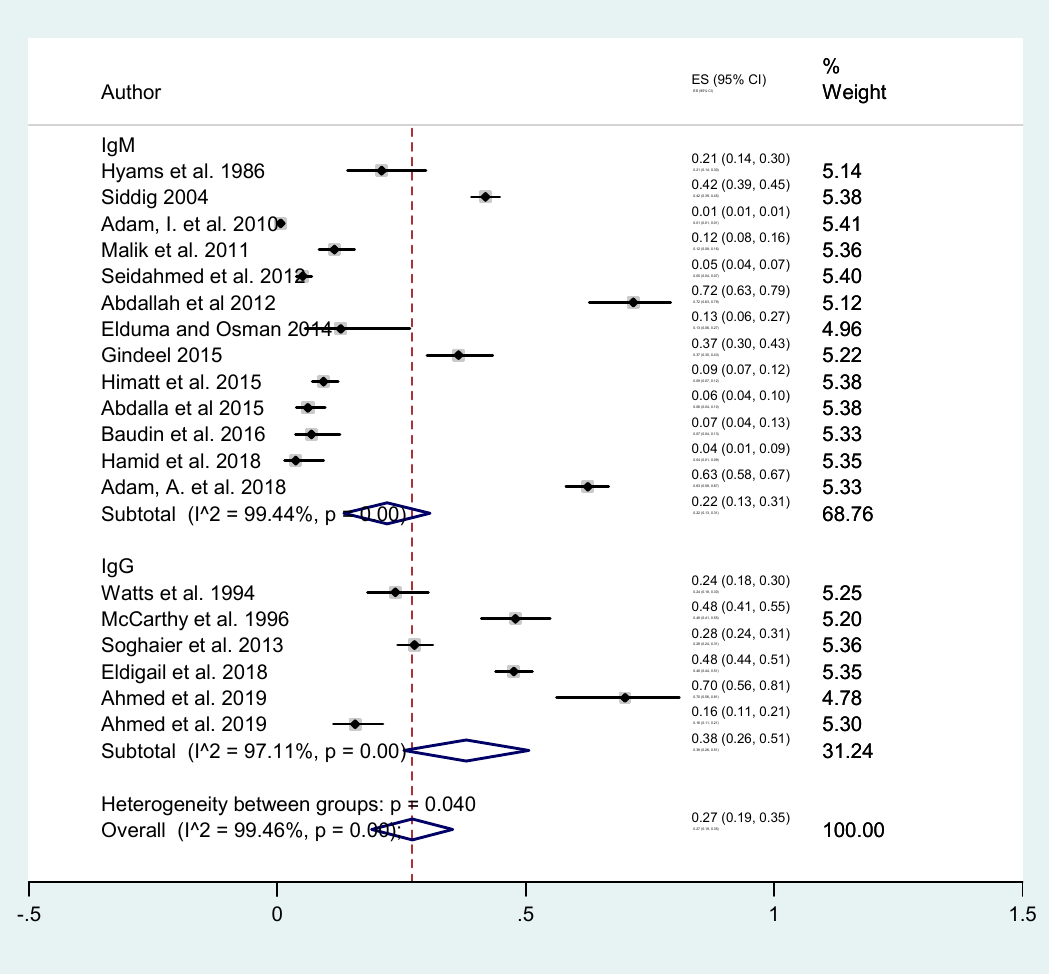
Figure 5. The estimated burden of dengue based on sub-group analysis according to diagnostic test. Additionally, the regional prevalence of the disease was estimated by sub-group analysis according to the geographical location of the studies site: North, East, South, Central, or Western Sudan (Figure 6). The estimated seroprevalence of DENV infections was 23% (95% C.I. 14–31%) in East Sudan, 43% (95% C.I. 40–45%) in Central Sudan, 24% (95% C.I. 18–30%) in North Sudan, and 36% (95% C.I. 18–55%) in Western